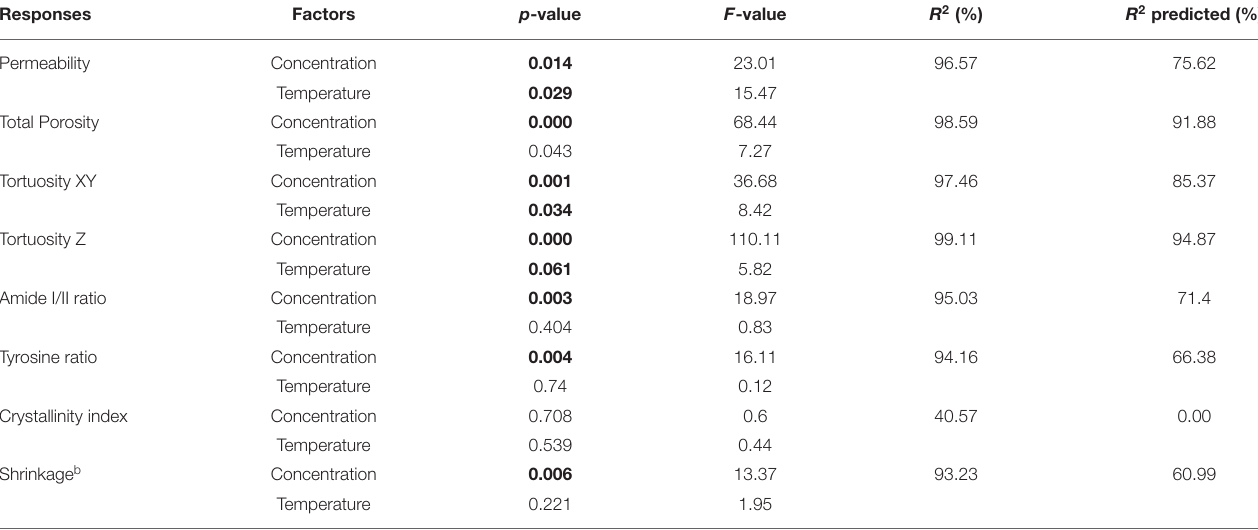
TABLE 3 | ANOVA a and regression analysis of the factorial design